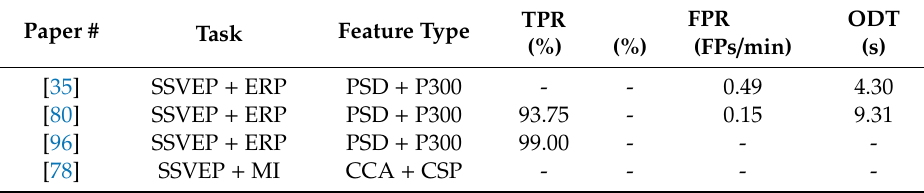
Table 5. List of electroencephalography (EEG)-based hybrid brain-switches. Note that one study [78] did not report any performance metrics. CCA, canonical correlation